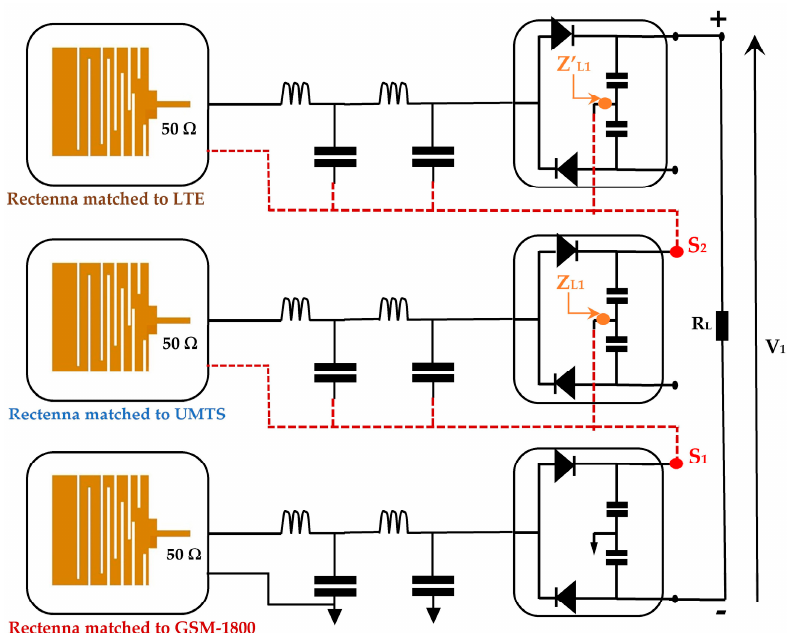
Figure 14. First architecture with three rectennas matched to GSM-1800, UMTS, and LTE-2.6. Z L1 , Z’ L1 are the impedances at the selected points.